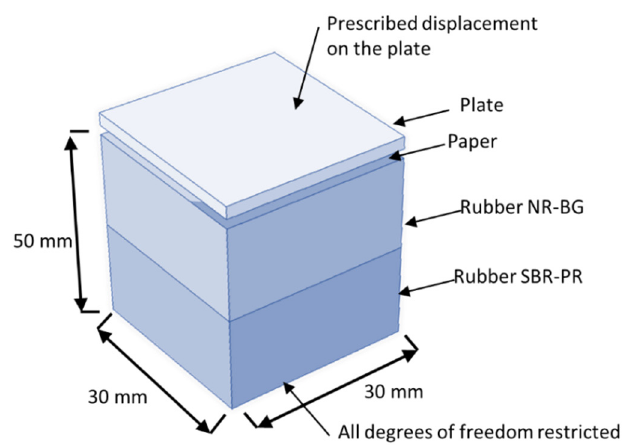
Figure 4. Model dimensions, characteristics, and boundary conditions.